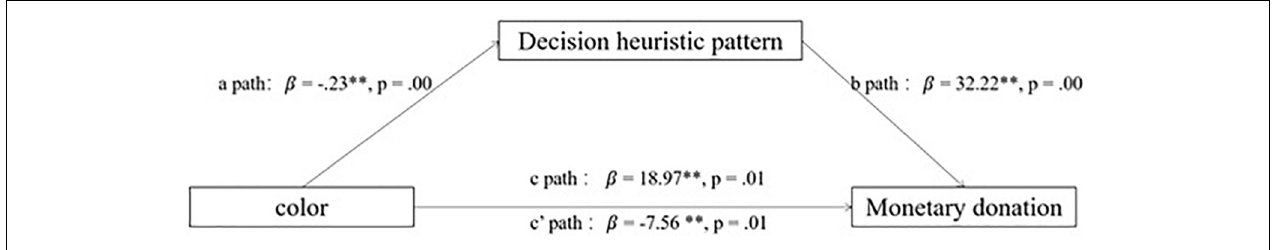
FIGURE 3 | Mediation